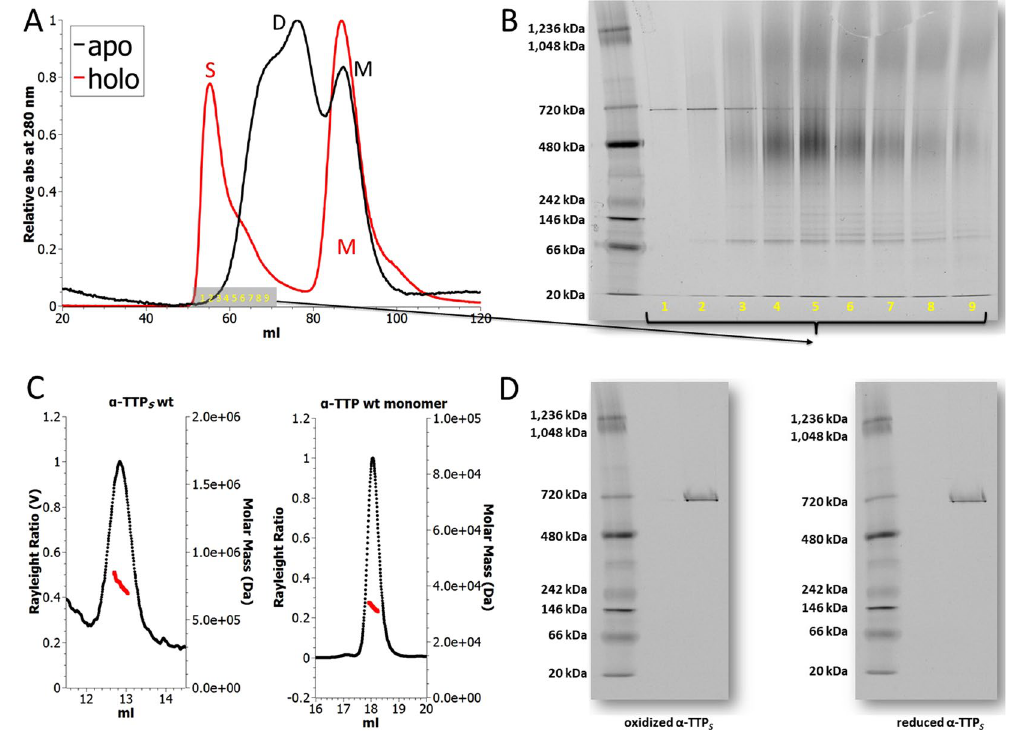
Figure 1. Formation of α -TTP homo-oligomers in presence of α -Tol. ( A ) SEC traces of apo- α -TTP (black trace) and α -TTP (red trace) in a preparative SEC setup. ( B ) Native PAGE of peak fraction S